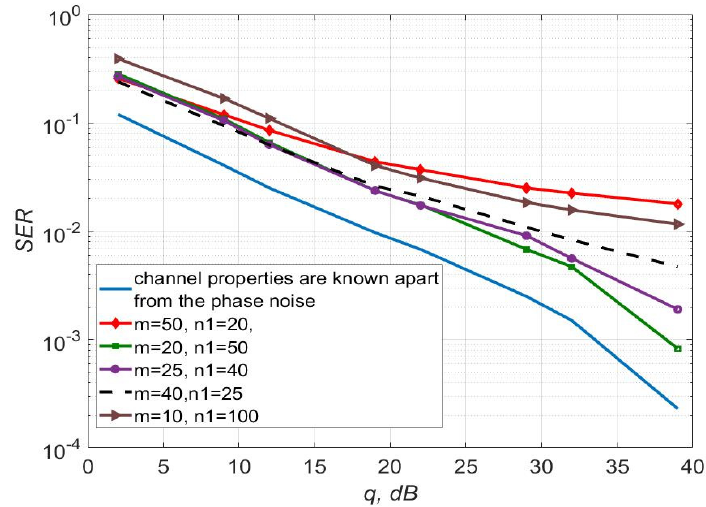
Figure 13. SER of 4-QAM versus SNR per bit; the algorithms, described by Equations (5)–(9) and (12) with p = 1 was used for K 0 = 1 and different values of m and n .